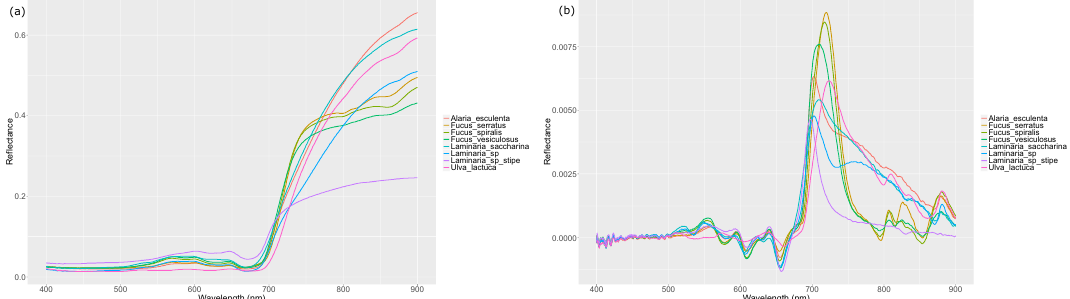
Figure 4. Averaged spectral reflectance per species: ( a ) Raw spectral reflectance. ( b ) 1st Derivative spectral